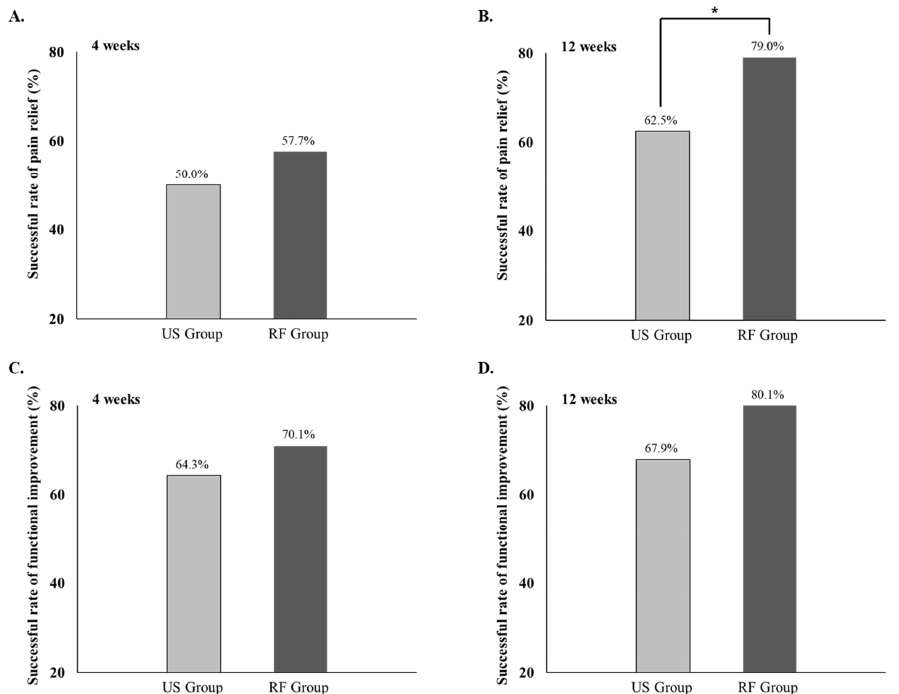
t -test (within groups, baseline vs. at 4 weeks, baseline vs. at 12 weeks), b Independent t -test (between groups, RF vs. US), c Time effect-Repeated measures of ANOVA between groups analysis was ap- plied: Baseline, 4 and 12 weeks after treatment between groups. Figure 2 shows the successful rate of pain relief and functional improvement on treatment completion after 4 and 12 weeks. In terms of successful outcomes in NRS, the RF group showed a significantly higher rate of successful pain relief (79.0%) at 12 weeks after treatment compared to the US group (62.5%, p = 0.048). There was no significant difference in the proportion of successful functional improvement between the two groups at 4 and 12 weeks after treatment.